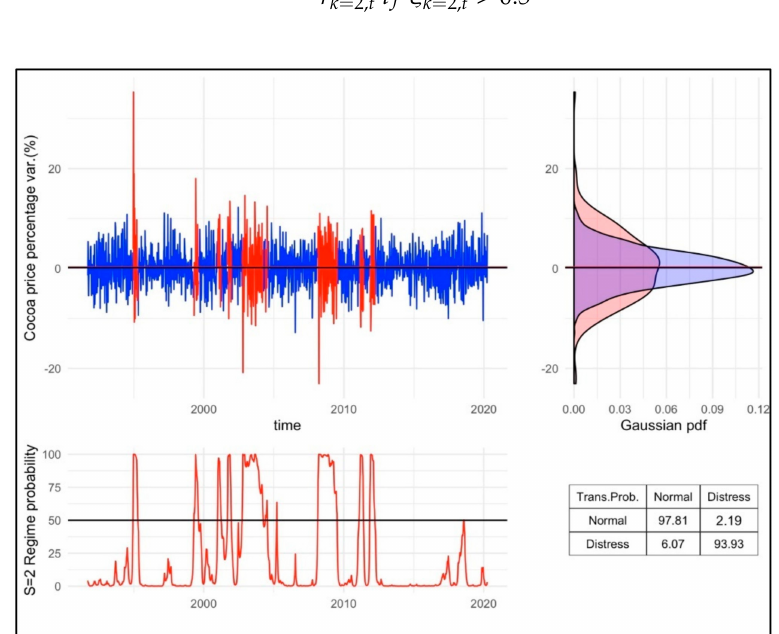
Figure 2. The two-regime Gaussian stochastic process of the cocoa future